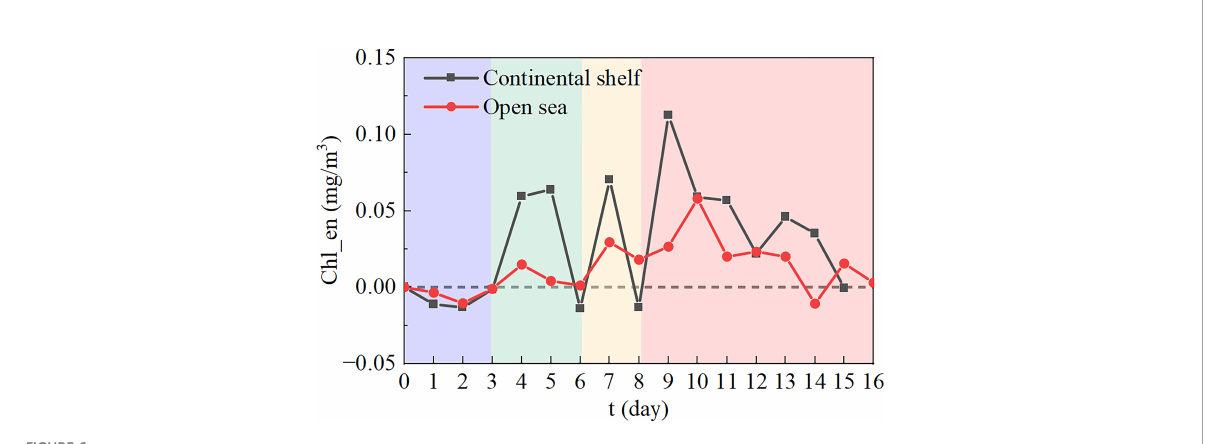
FIGURE 6 Timeseries of Chl_en in the continental shelf area (black curve) and open sea area (red curve). The shading indicates different stages of variations in